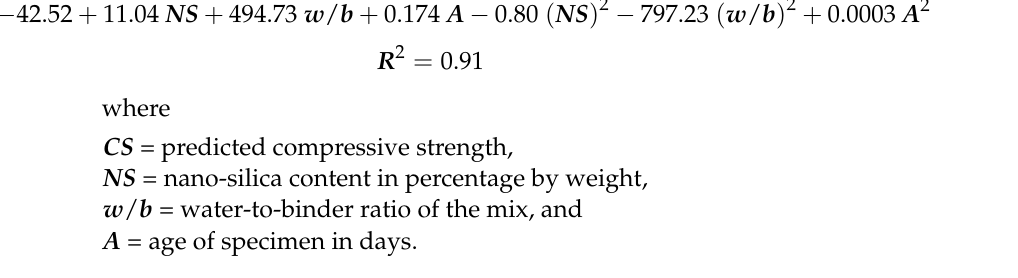
conducted to collect more data samples. It is anticipated that using additional data samples would improve the predictive accuracy of the